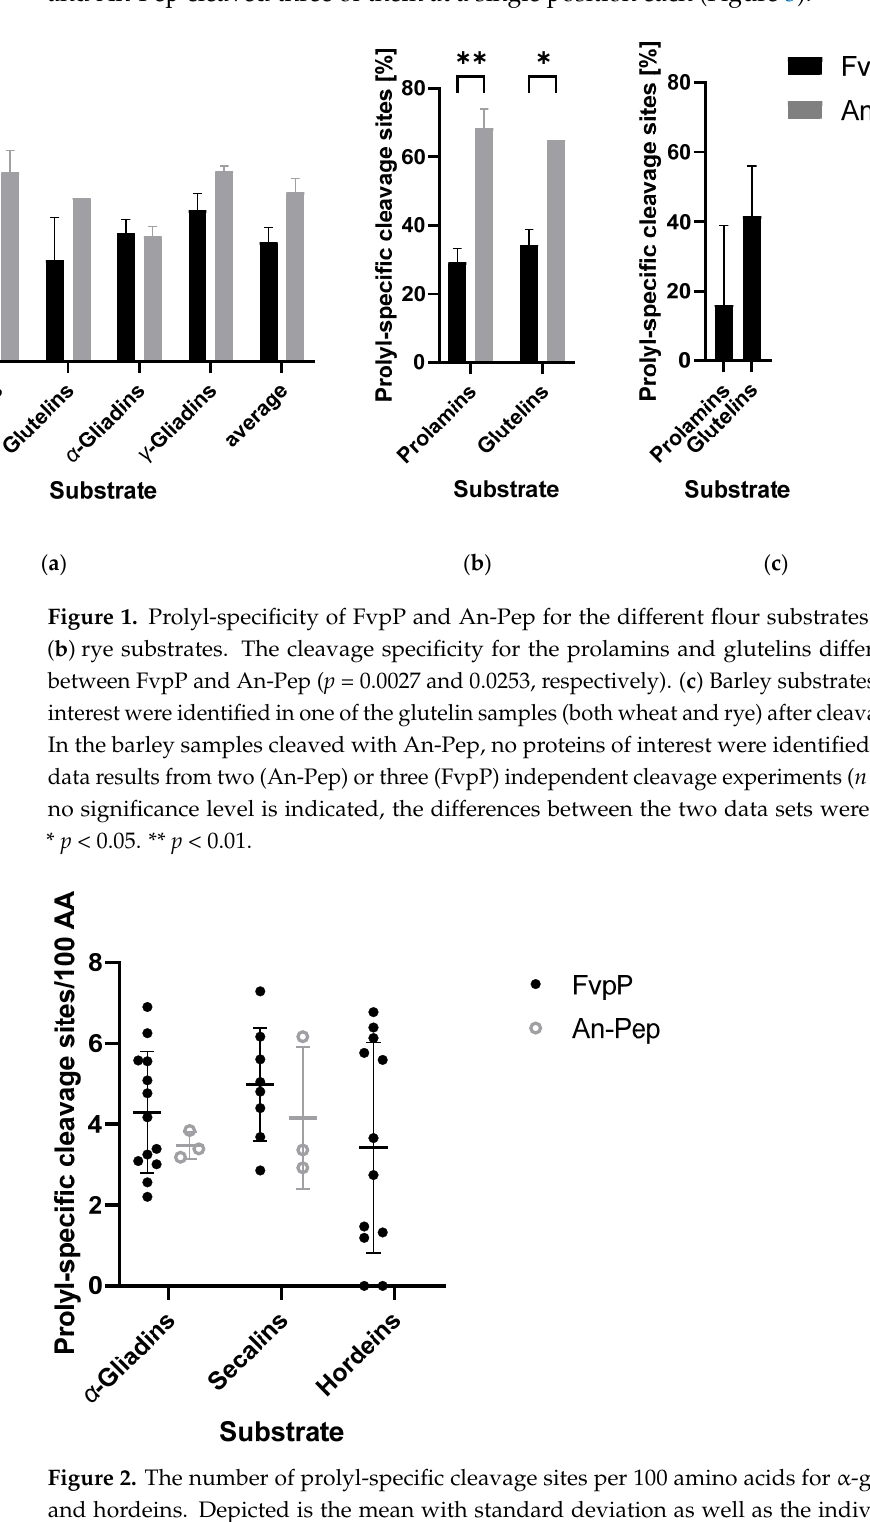
sequence. Of these six epitopes, FvpP was shown to cleave all at two separate positions, and An-Pep cleaved three of them at a single position each (Figure 3).